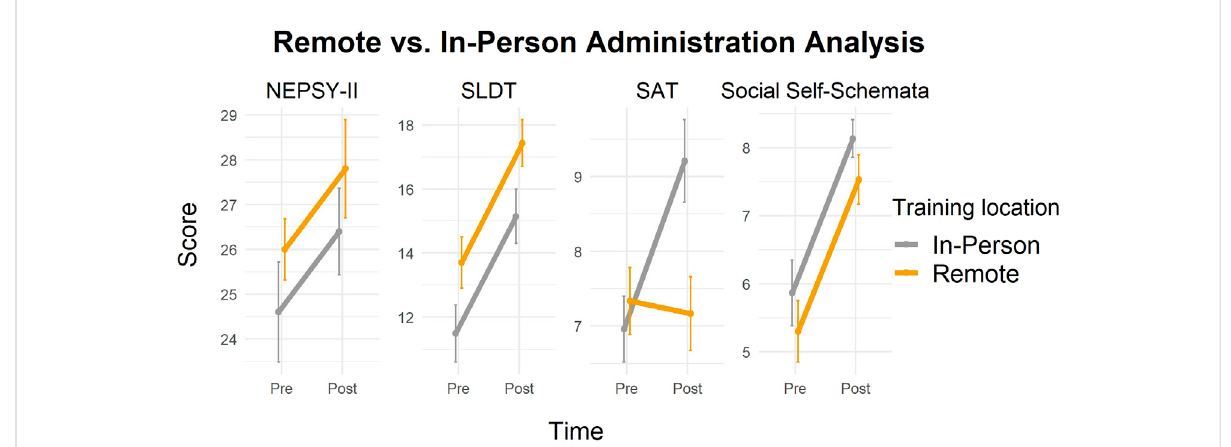
FIGURE 7 Changes inassessment task scores inparticipants with in-person vsremotetraining. Emotion recognition(NEPSY-II),social inferencing (SLDT), and social self-schemata increased from pretest to posttest in the same manner in participants regardless of training location.